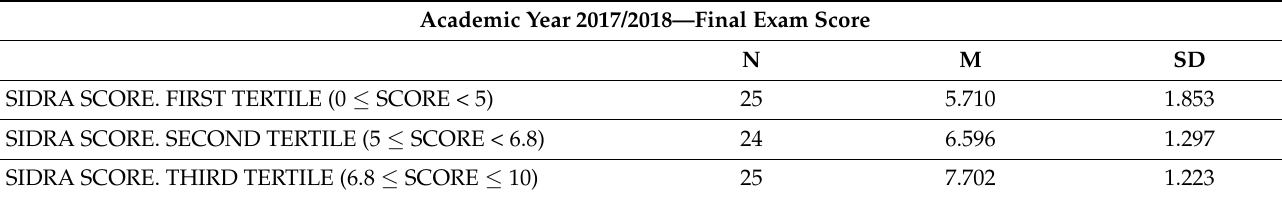
Table 3. Descriptive Statistics for Final Exam. “N”: Number of students; “M”: Mean; “SD”: Standard deviation.